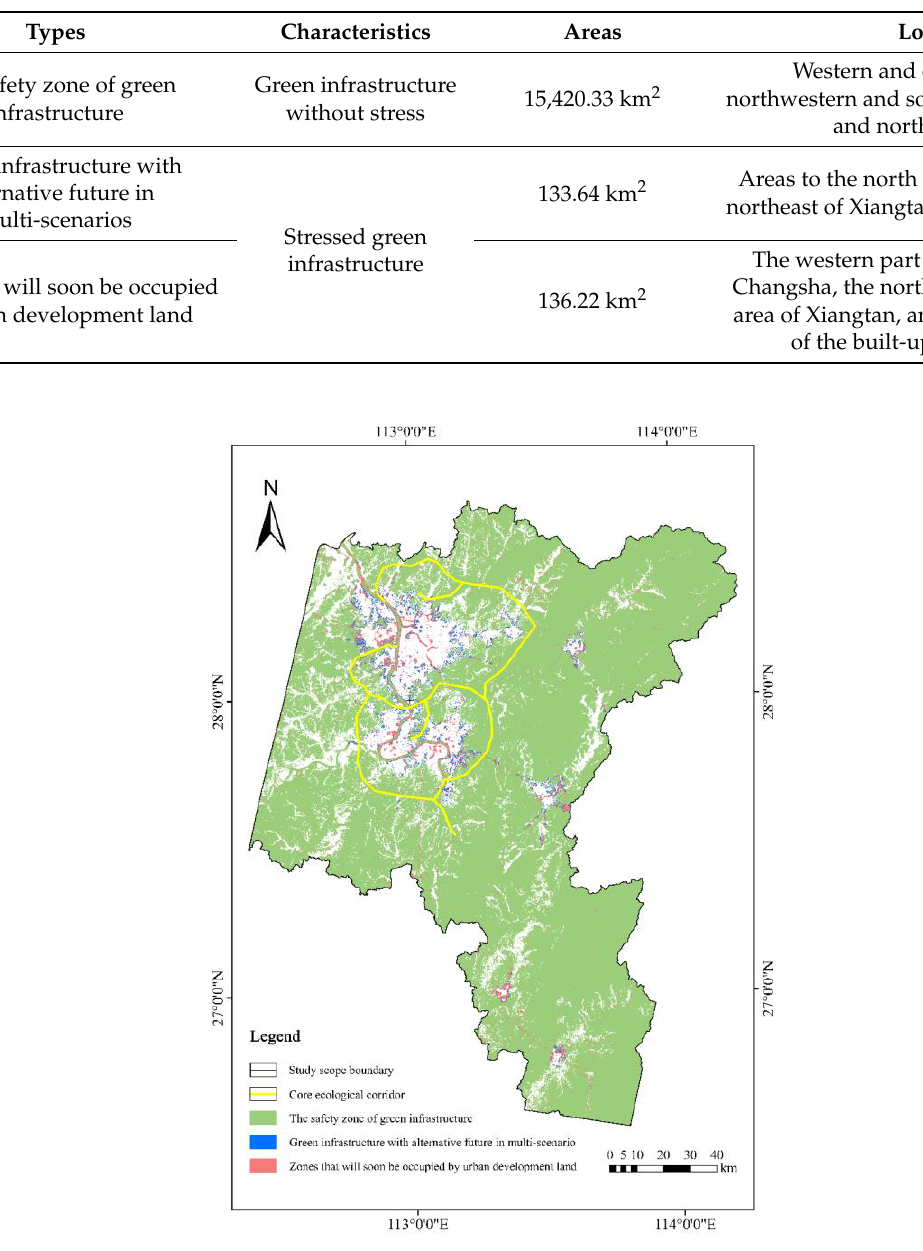
Table 7. Identification of key green infrastructure control areas.